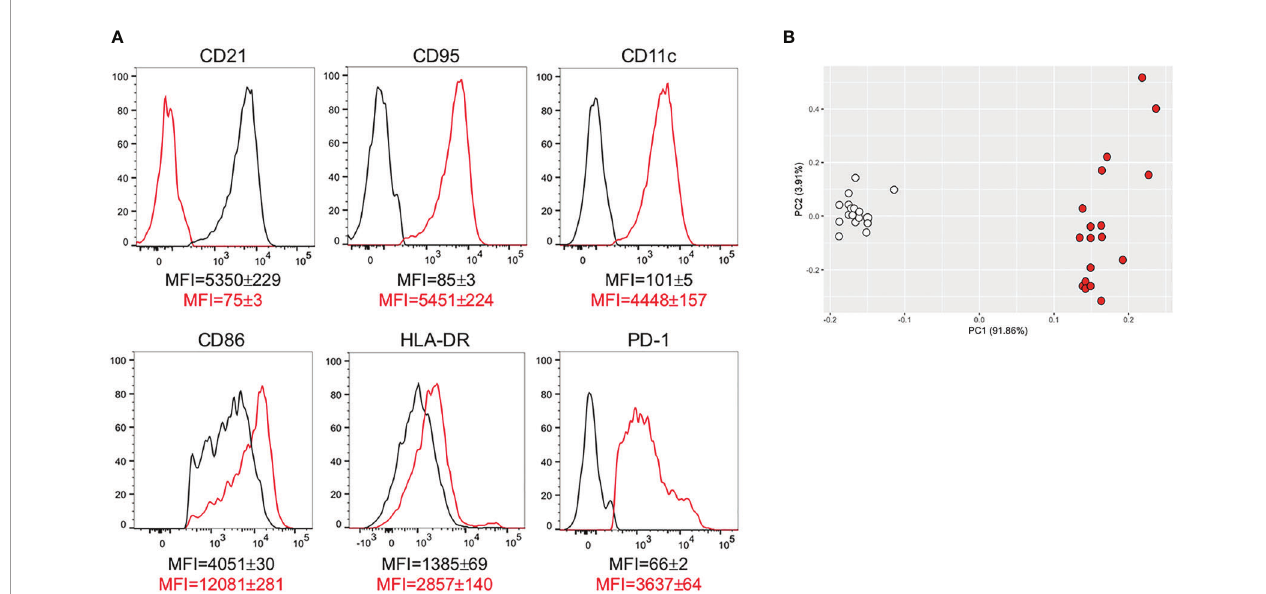
FIGURE 4 | DN B cells are characterized by higher expression of IA markers associated with autoimmunity. (A) Cells were stained to evaluate the expression of several markers of IA on DN B cells from individuals with obesity and from lean controls. Results show mean fl uorescence intensity (MFI)± SE for each marker in DN B cells from lean (black line) and obese (red line) individuals (18 individuals/group). (B) PCA analysis with the axes showing the percentage of variation explained by PC1 and PC2. Each symbol indicates an individual. White symbols: lean individuals. Red symbols: obese individuals.